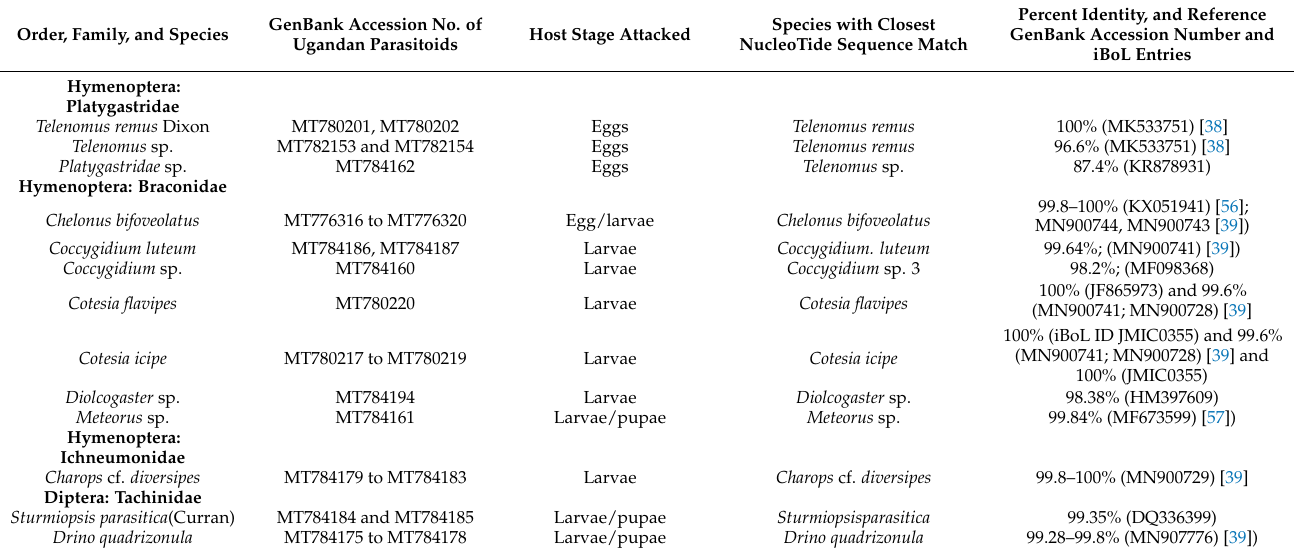
Table 1. Parasitoid species recovered from eggs and larvae of Spodoptera frugiperda collected from maize fields in Uganda, 2017 and 2019 and their sequence identity as compared with publicly available sequences from GenBank and iBoL entries. Order, Family, and Species